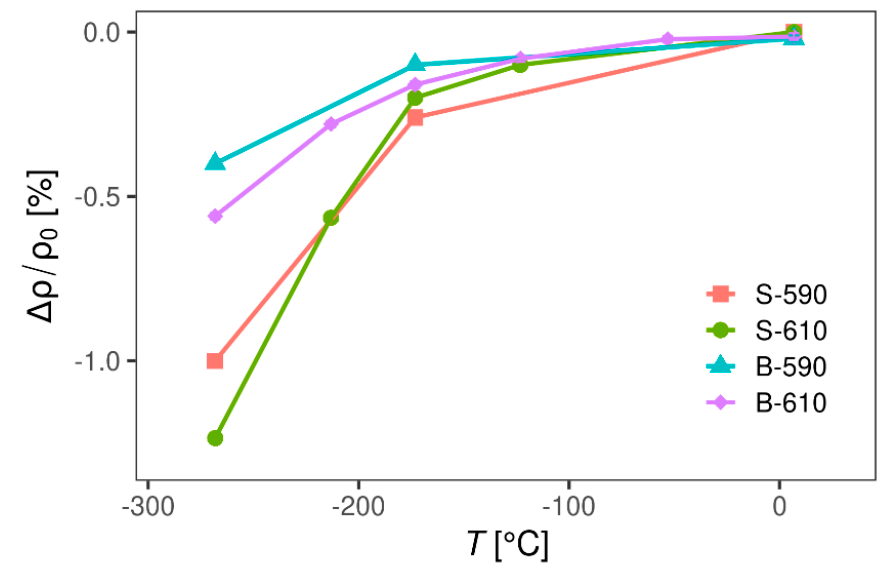
Figure 9. Magnetoresistance of SnO 2 samples as function of temperature. Error bars are omitted in plot because they are order of experimental point symbol size.